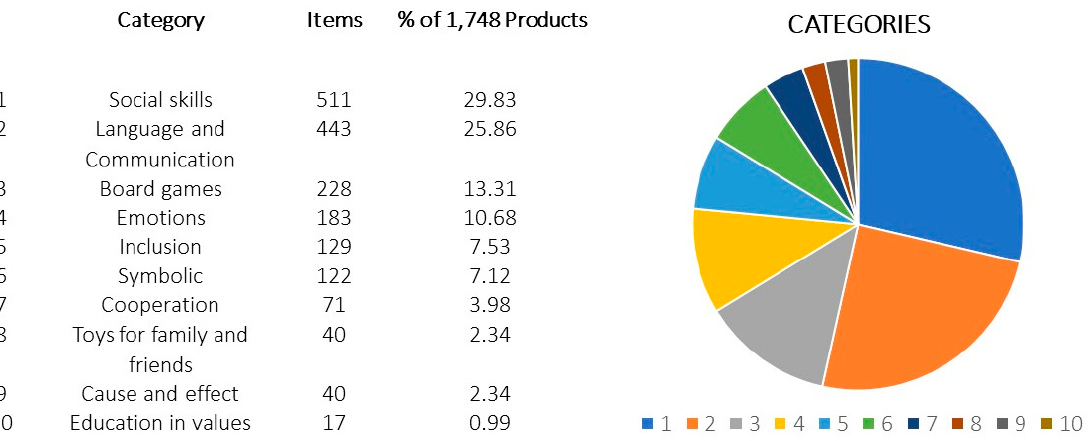
Figure 9. Categories of toys related to collaboration.